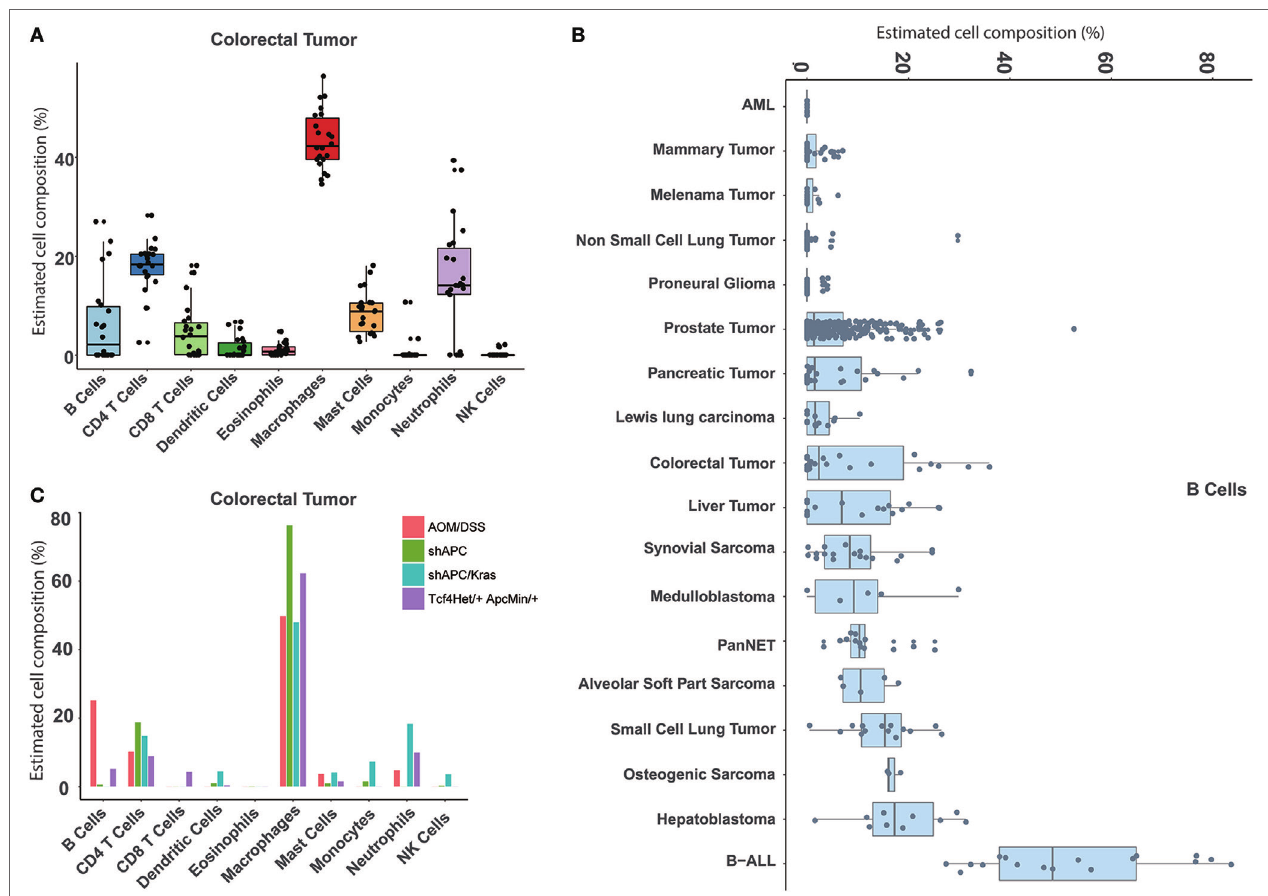
FIGURe 5 | Atlas of immune cell compositions in mouse tumor tissues. (A) Inferred proportions of 10 immune cells in colorectal tumors. (B) Distribution of B cell proportion across 18 tumor types. (C) Comparison of the immune cell compositions in the same tumor type (colorectal tumors) with four different inducing